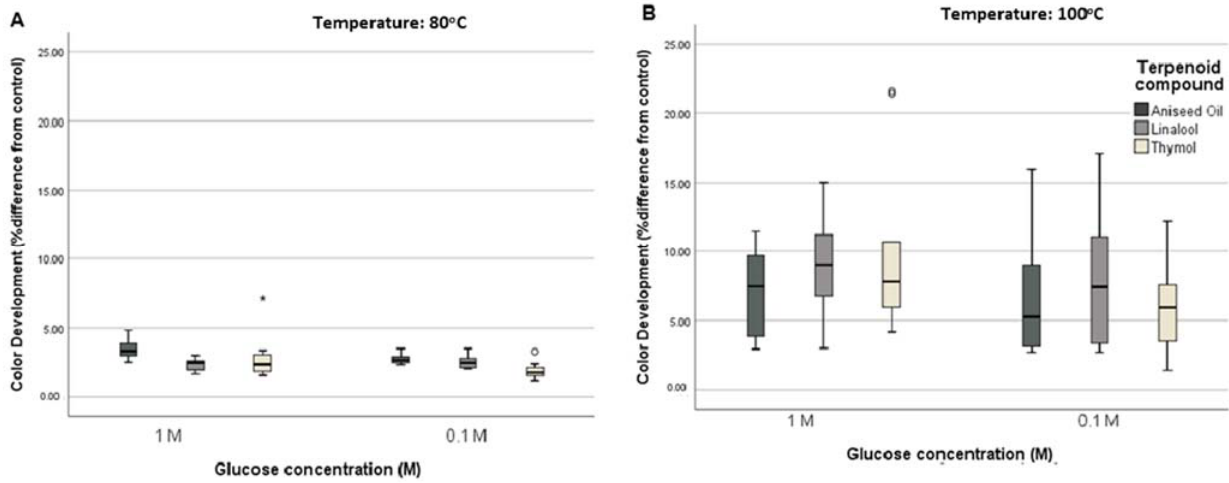
Figure 1. The effect of terpenoid compounds on color development in heated glucose/lysine solutions at 0.1 M and 1 M glucose at pH 7.2 and ( A ) 80 °C and ( B ) 100 °C. Symbols (*, °) outside the boxplots indicate outliers.